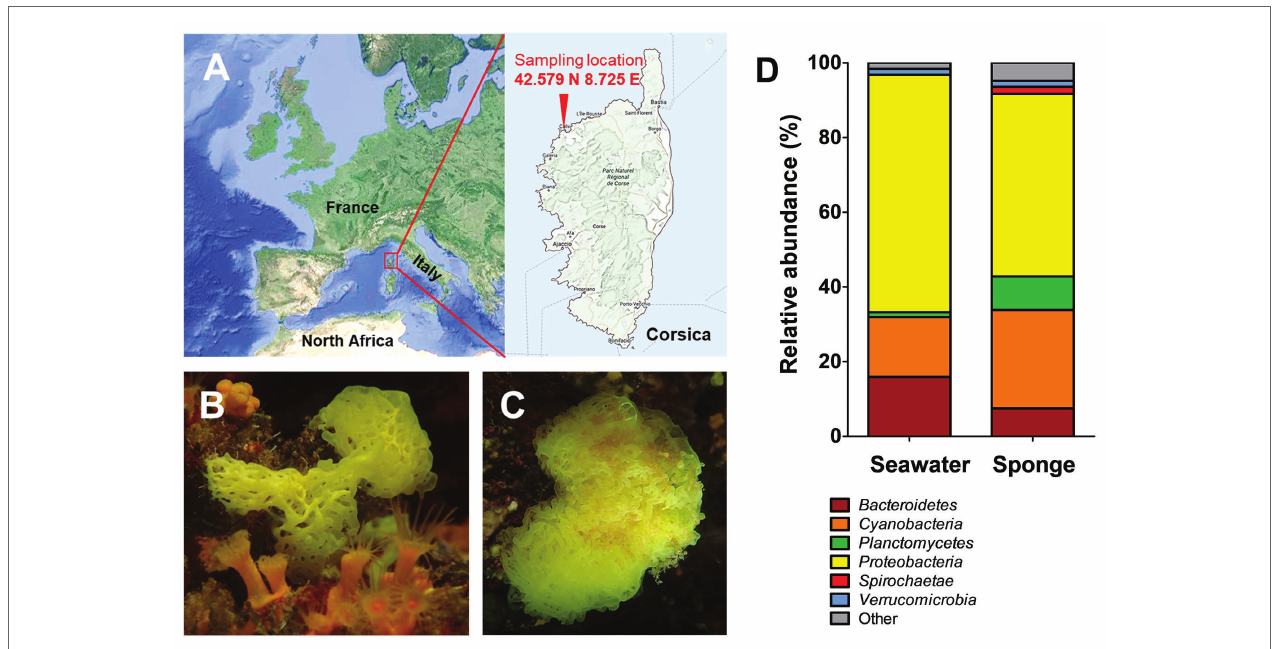
FIGURE 1 | Sampling location and results of the cultivation-independent analysis of the Clathrina clathrus -associated bacterial community. Samples were taken close to Calvi on the Northern coast of the island Corsica, France ( A ; exact coordinates are given in the picture). Picture of the investigated calcareous sponge as side view (B) and top view (C) . Determination of the bacterial community composition of C. clathrus on bacterial phylum level compared to surrounding seawater (D) . Data for the surrounding seawater was taken from a previous study (Kohn et al.,